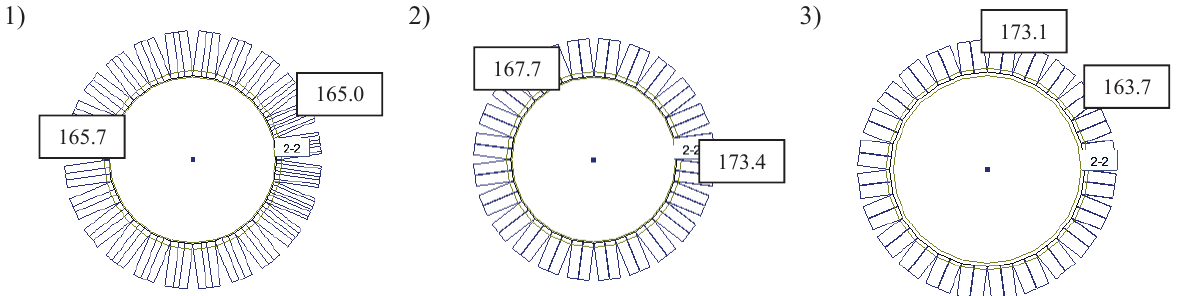
Fig. 8. Diagrams of vertical moments M N , kNm/m ( 5.0/ =